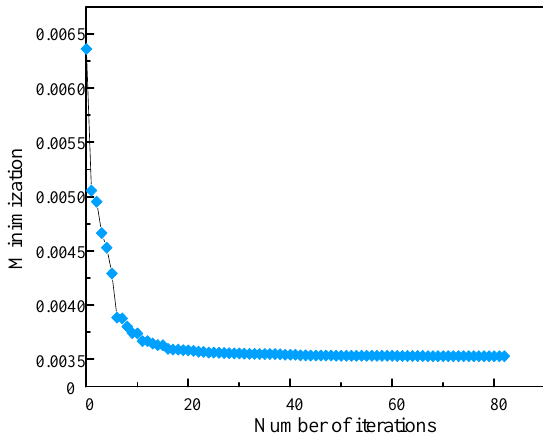
Figure 10. Optimization curves of parameters: ( a ) A ; ( b )